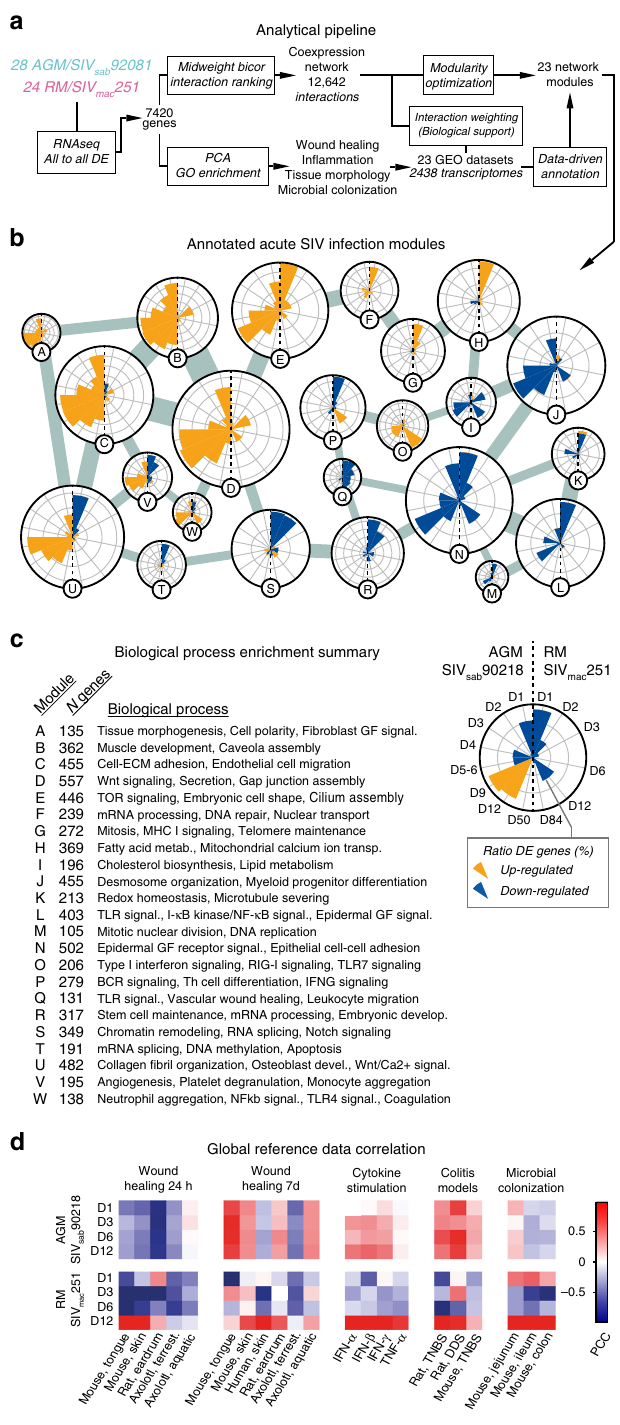
Fig. 2 CGSA bioinformatic pipeline overview. a Systems biology approach to improve identi fi cation and annotation of the Acute SIV Co-Expression Network in acute SIV infection data. (Lower path) GO enrichment analysis